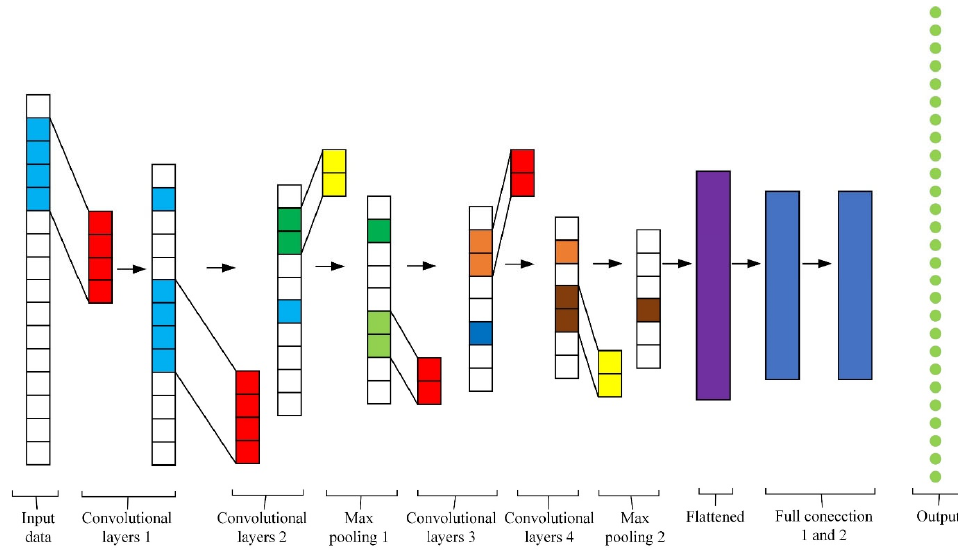
Figure 3. CNN extracted data feature structure map from the CNN-SVM model. The number of filters in the first two layers is 64, and in the latter two layers is 32. The first two filters have size 4; the last two have size 2. The window size of the maximum pool layer is 2. The activation function of the fully connected layer adopts the SeLU function.